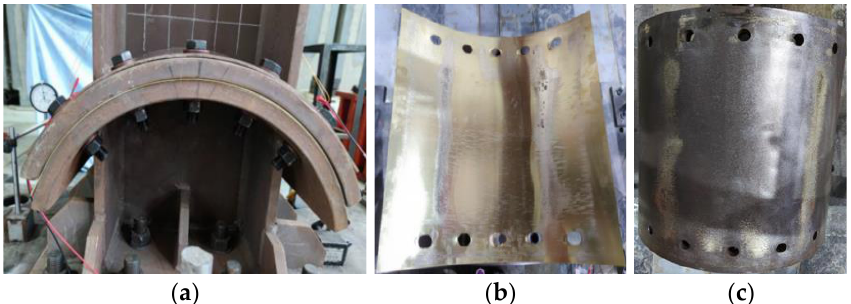
( c ) Figure 7. Influence of axial compression ratio on wear of lower arc end-plates: ( a ) H350 − 1 − 1; ( b ) H350 − 1 − 2; ( c ) H350 − 1 − 3. H350-4-1 added a thin brass plate between the arc end-plates based on the test con-